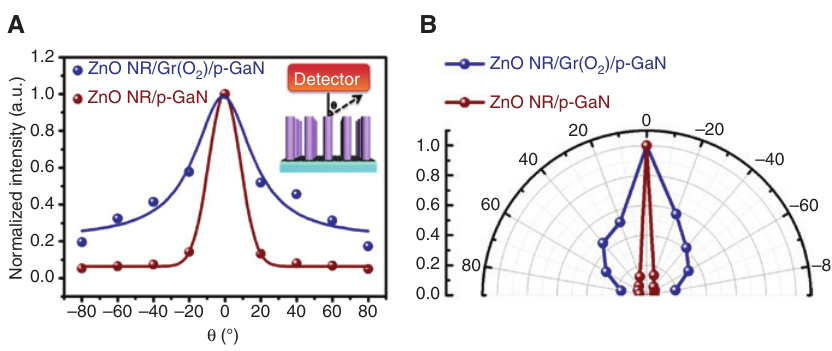
Figure 8: Measured angle-resolved integral intensities of both LEDs in (A) rectangular coordinates and (B) polar coordinates. The curves are normalized by the axial direction EL